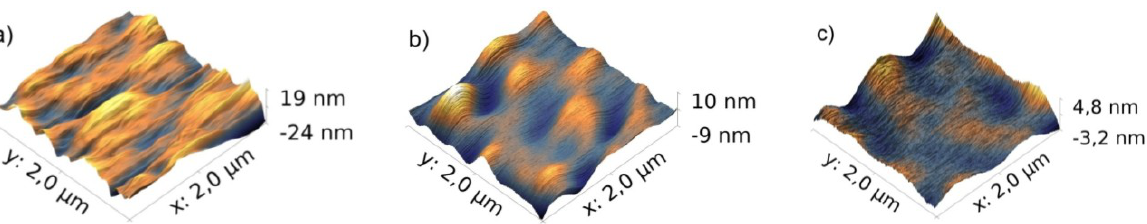
Figure 7. The surface of a PMMA fiber as imaged by AFM. The corresponding RMS roughness is given in brackets: ( a ) Untreated fiber (5 nm); ( b ) fiber after coating with PVA (2.4 nm); ( c ) fiber after subsequent coating with PVA and PMMA (0.9